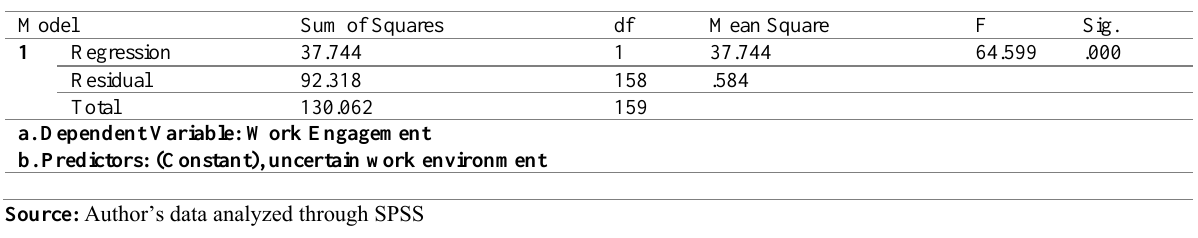
Table 12: ANOVA for uncertain work environment on work